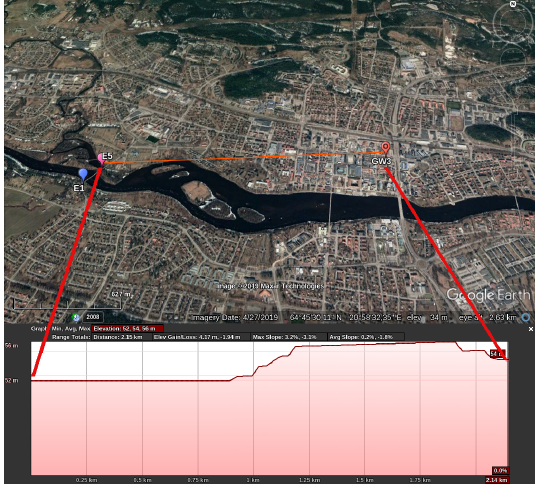
Figure 8. Elevation profile for E5 in relation to GW3 created with Google Earth [45].